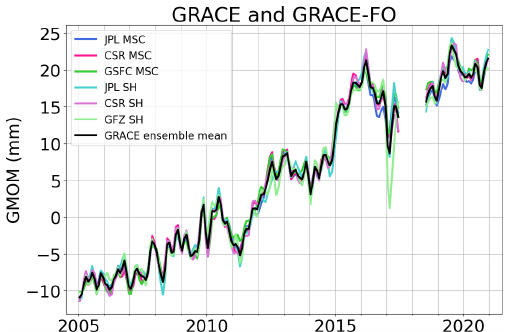
Figure 1. Global mean ocean mass time series from GRACE and GRACE-FO mascon (MSC) and spherical harmonics (SH) datasets. The black curve corresponds to the ensemble mean. Linear trends for all time series over different periods of time are provided in Table